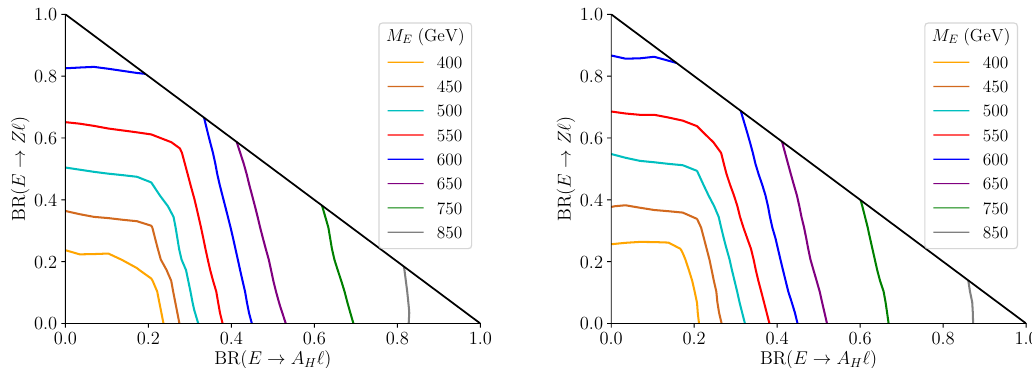
Figure 9 . 95% C.L. lower bound on the VLL mass M E as a function of BR( E → A H ‘ ) and BR( E → Z‘ ) for M A = 1 GeV (left panel) and M A = 98 GeV (right panel). The limits are given H H as contour plots for fixed values of M E in which the region above and to the right of the curves is excluded and they are computed from a combination of the analyses described in the previous √ section with s = 13 TeV and an integrated luminosity of L = 139 fb − 1 . The contours correspond to masses that grow from the (0 , 0) vertex